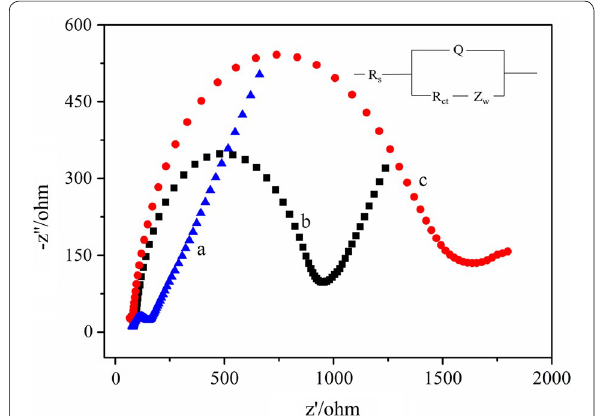
Fig. 2 The EIS of 10.00 mM [Fe(CN) 6 ] 3 − /4 − on the different electrodes. (a) The bare AuE, (b) the apt/AuE, (c) the CAs-cDNA/apt/AuE. Inset: the equivalent circuit